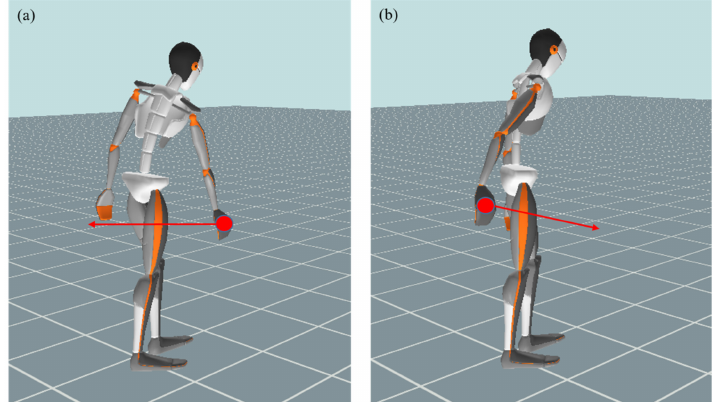
Figure 2. ( a , b ) Reference points and directions of movement in the habitual vacuuming cycle: ( a ) distal turning point and start of pulling phase, ( b ) proximal turning point and start of pushing